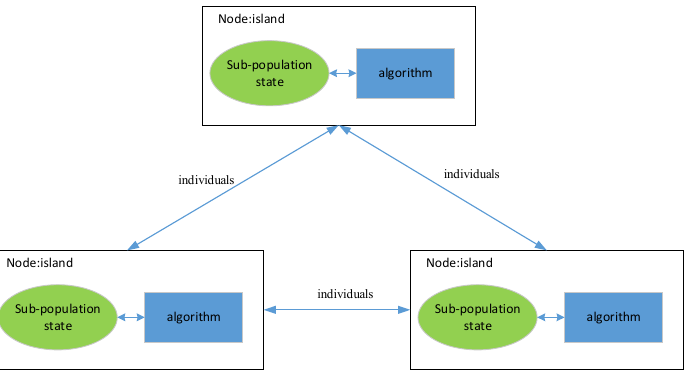
Figure 6. Communication between nodes in the classical island model.